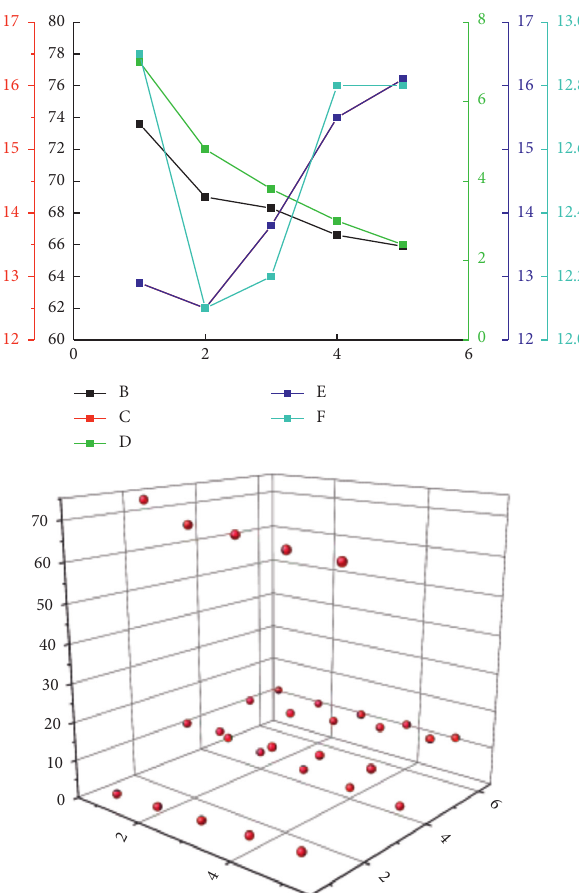
Figure 8: Overall efficiency comparison results.